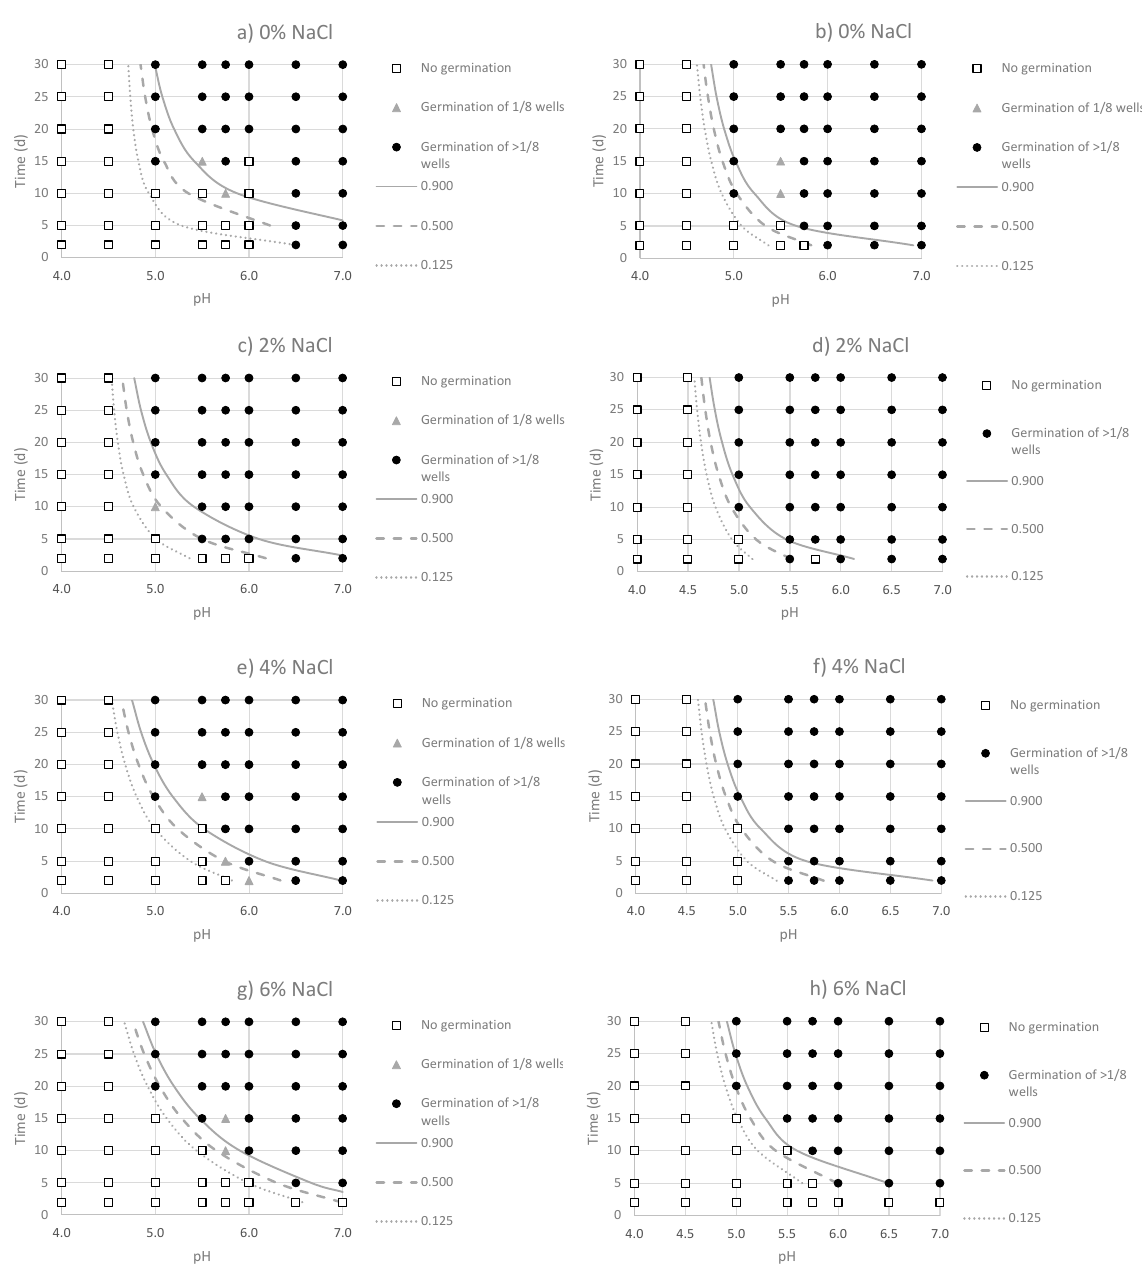
Figure 2. Contour plots for the observed germination responses and predicted probabilities ( p = 0.125, p = 0.500 and p = 0.900) for the non-adapted (panels a , c , e , g ) and acid-adapted strains (panels b , d , f , h ) of C. sporogenes at NaCl concentrations of 0%, 2%, 4% and 6% w / w . The results showed that at acidic pH values (5.0), the acid-adapted strains germinated at 10 days’ incubation at NaCl concentrations ≤ 2% (Figure 1b), while the germination time of the non-adapted strains increased until 15 days at these NaCl concentrations (Figure 1a). According to the model’s predictions, the growth boundary is set at pH 5.0, NaCl 3.95% and 10 d incubation for non-adapted strains, while this boundary is shifted to an increased NaCl concentration of 4.92% (pH 5 for a 10-days incubation) for the acid-adapted